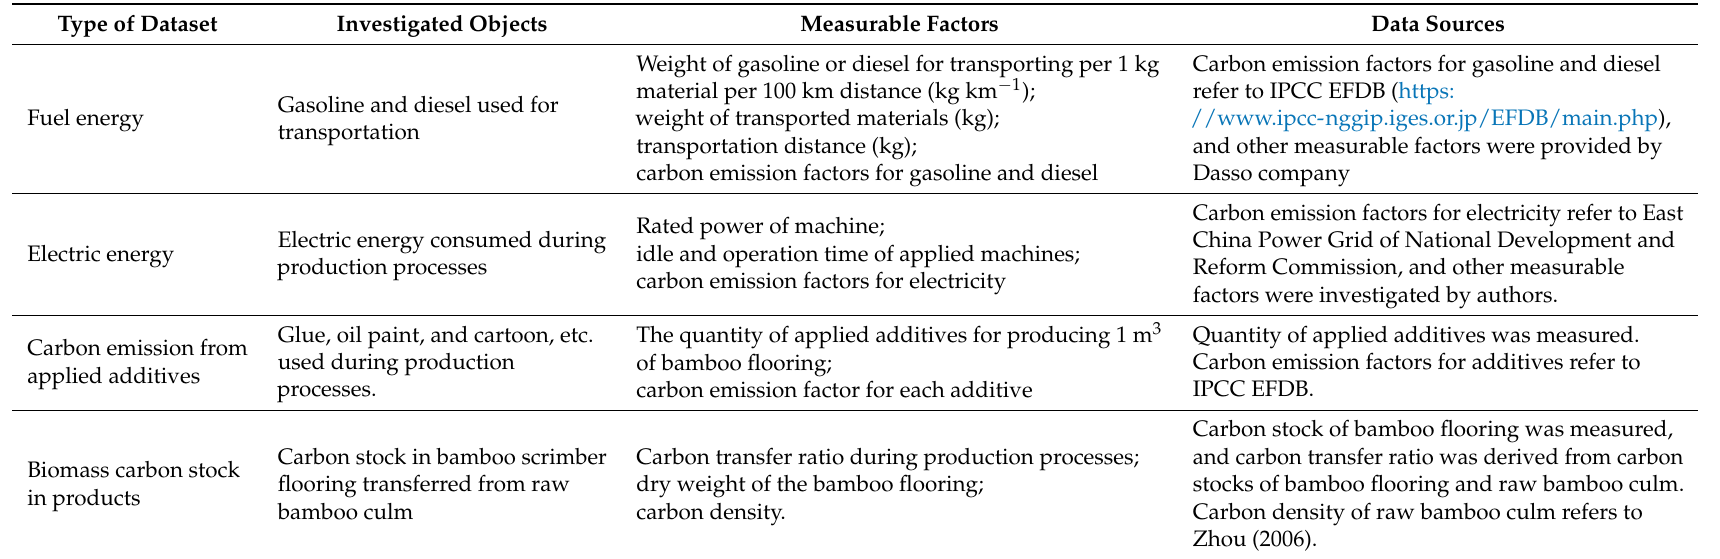
Table A1. Description of the dataset used for estimating the carbon footprint of bamboo scrimber